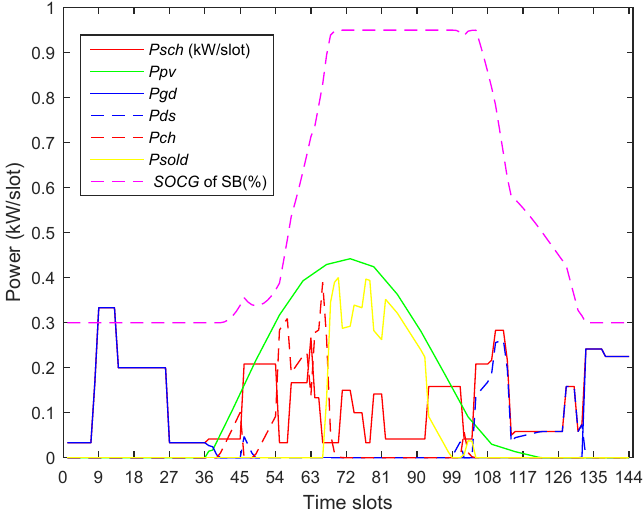
Figure 29. Load profile for maximal reduction in CE using 3S-ToUP (MS) for PDDR-RED-based HEMS.